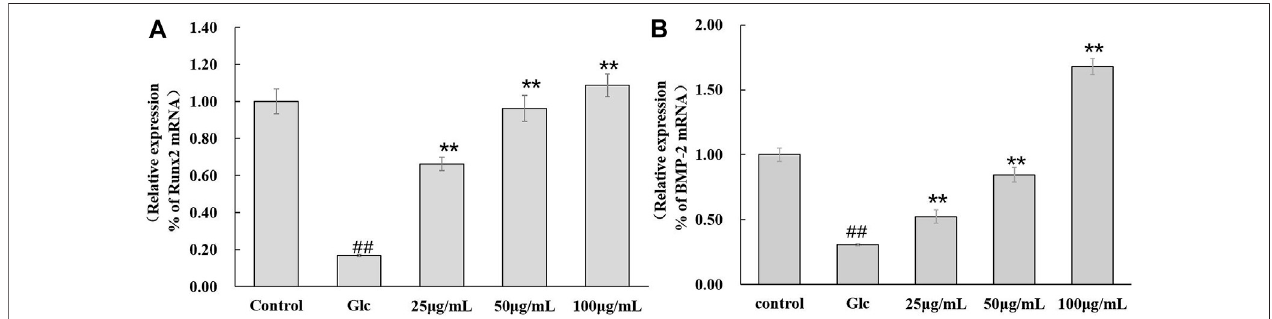
FIGURE 6 | The effect of DAI-1 on the relative mRNA expression of the osteoblast differentiation-related factors Runx2 (A) and BMP-2 (B) in a high-glucose environment. After 48 h oftreatment, the transcription levels of Runx2 and BMP-2in osteoblasts were quanti fi ed using quantitative real-time PCR. ## : p < 0.01, for high- glucose group vs .the control group; *: p < 0.05, **: p < 0.01, for the DAI-1and DAI-2 treated group vs . high-glucose